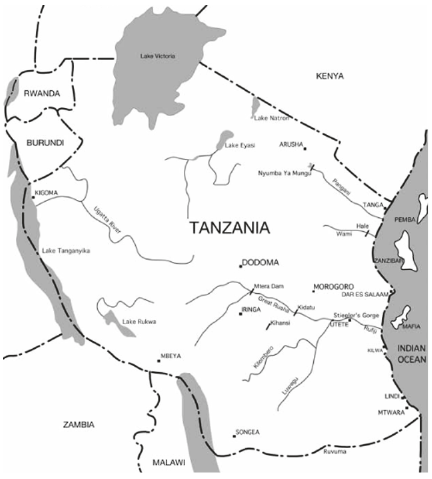
Figure 2: Tanzania’s key water ways and lakes